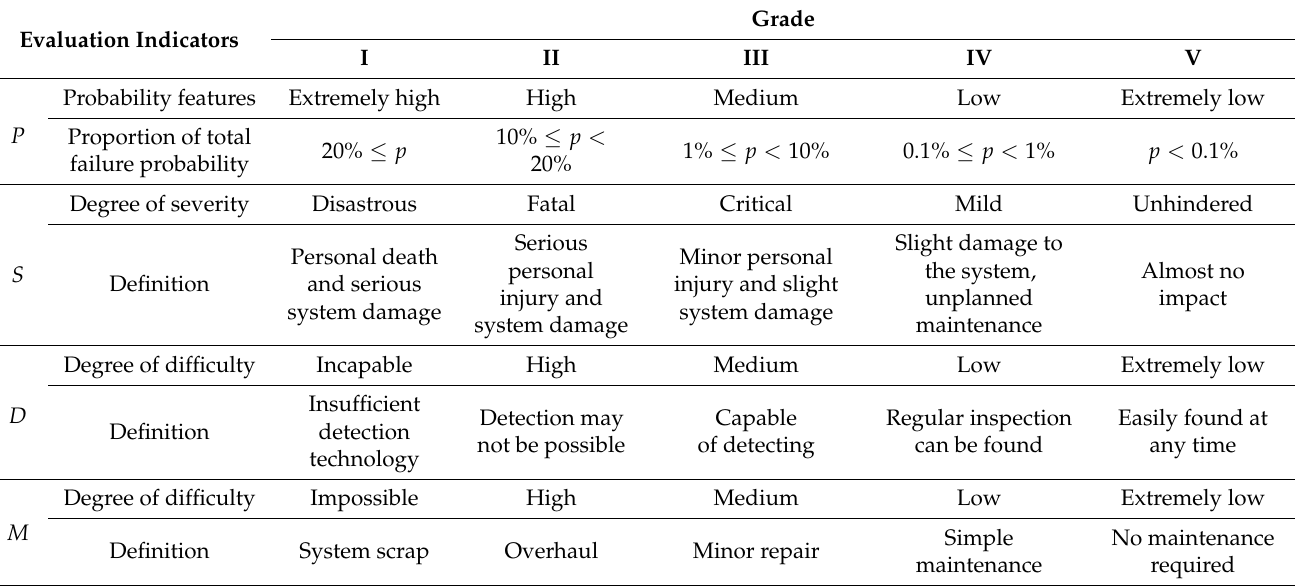
Table 1. RPN − M ’s evaluation